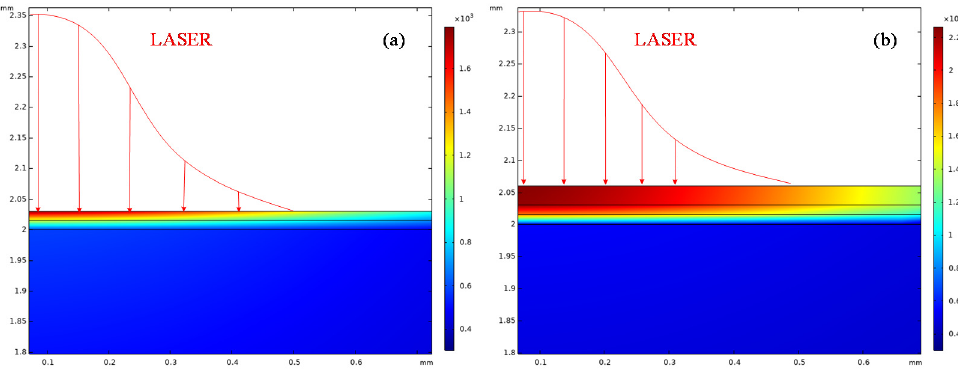
Figure 11. When the power density is 147.44 W/mm 2 , ( a ) the temperature field distribution of target 2 and ( b ) the temperature field distribution of target 3.